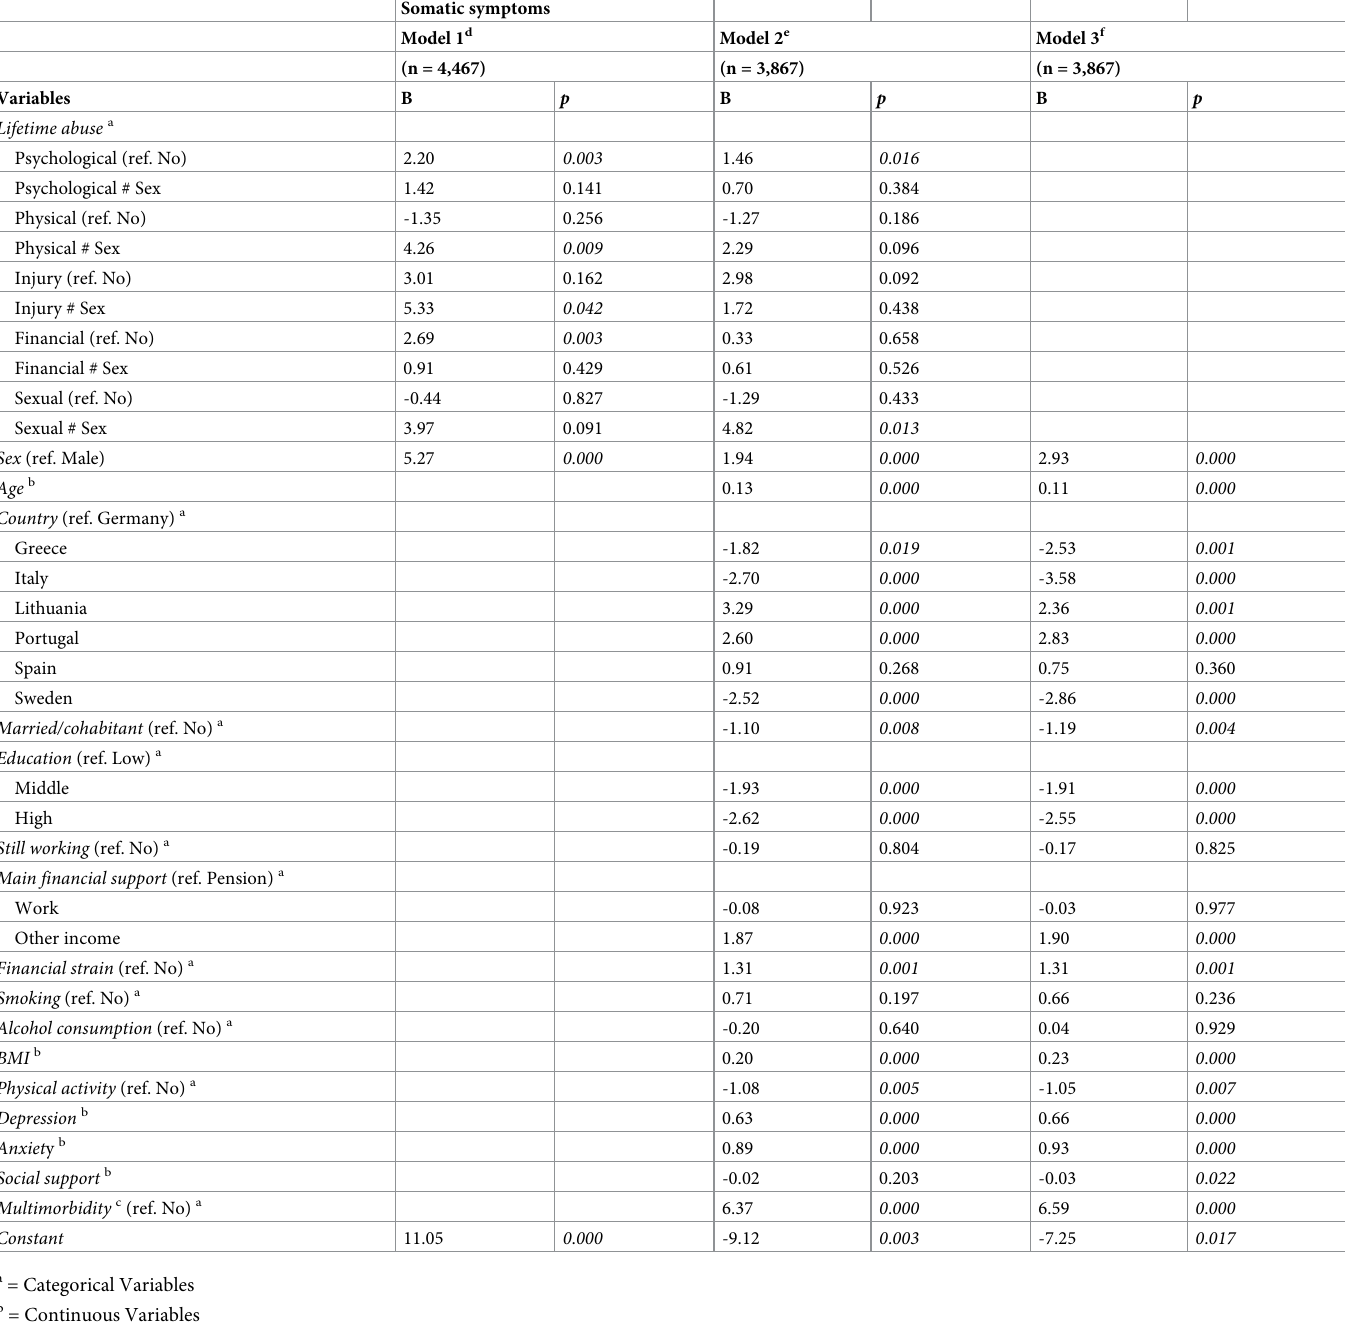
Table 3. Demographic/socio-economic variables and lifetime abuse associated with somatic symptoms in multiple linear regression analyses among older women and